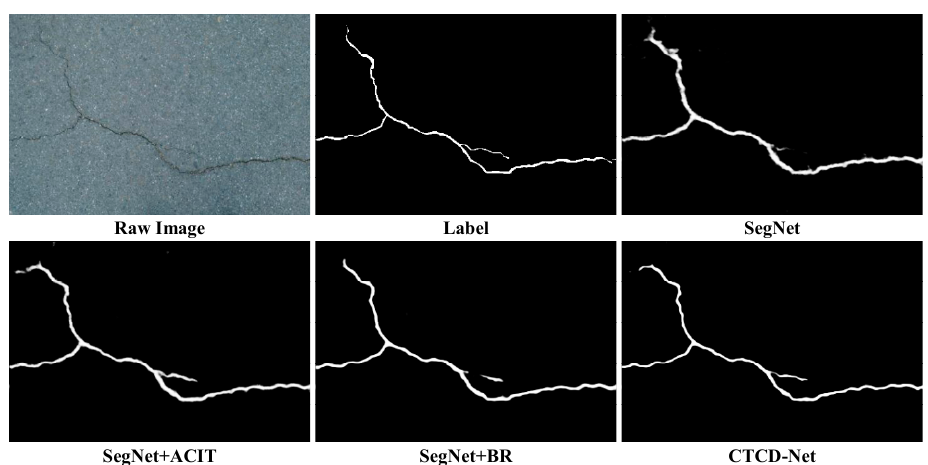
Figure 12. The visualization results of ablation experiments on CFD.